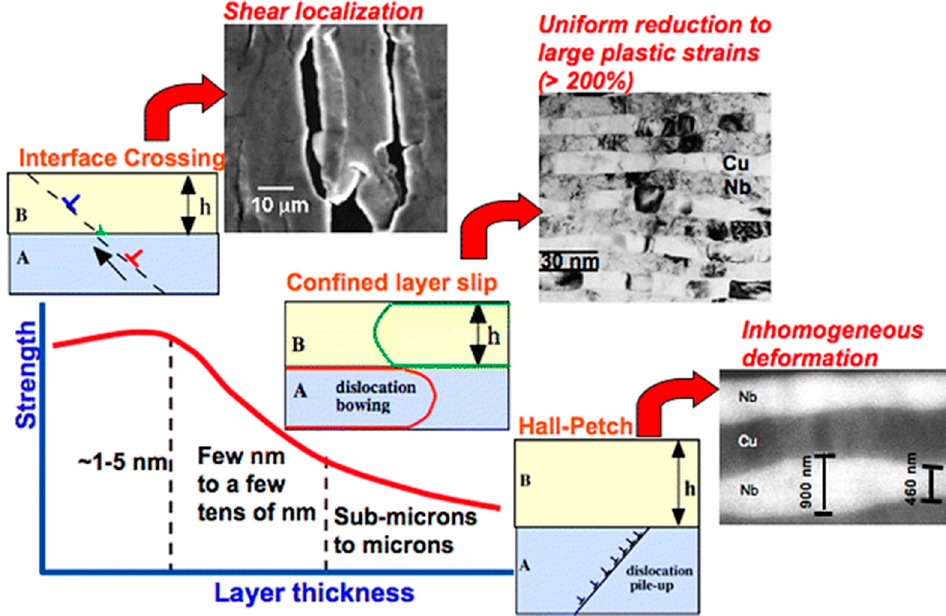
Figure 6. Schematic of the deformation mechanisms in metallic multilayers as a function of layer thickness from micrometer to nanometer range (The Hall–Petch mechanism of dislocation stacking can explain the relationship between layer thickness and strength at the submicron to micrometer scale. When the layer thickness is from a few nanometers to a few tens of nanometers, the constraining layer slip stress exceeds the interface slip transfer barrier, resulting in interface shear and strain localization, which limits uniform deformation).